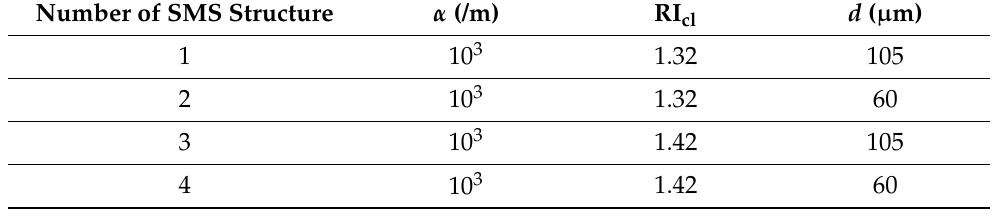
Table 2. Parameters of MMF in the SMS fiber structure.